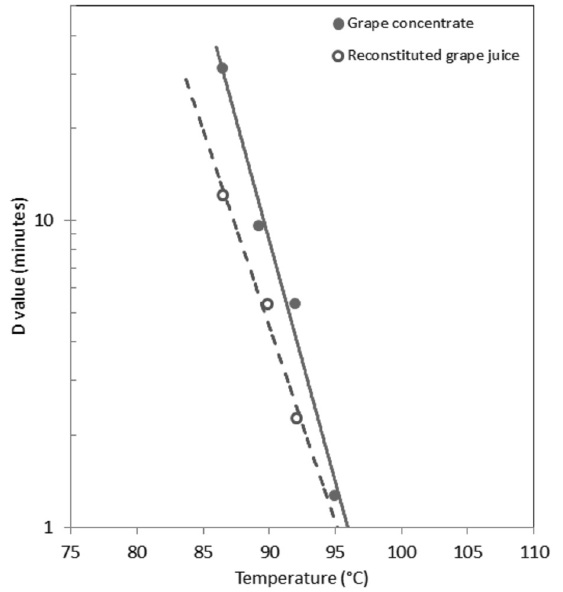
Figure 2. D values for B. fulva ascospores in concentrated and reconstituted grape juices (King et al.